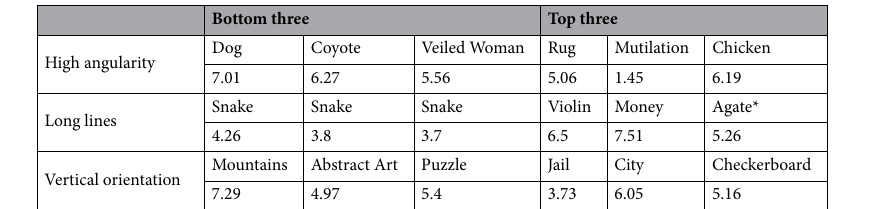
Table 1. The image descriptions and valence scores of the three images with the least and three images with the greatest number of pixels corresponding to the significant features shown in Fig. 2. *Agate is a type of